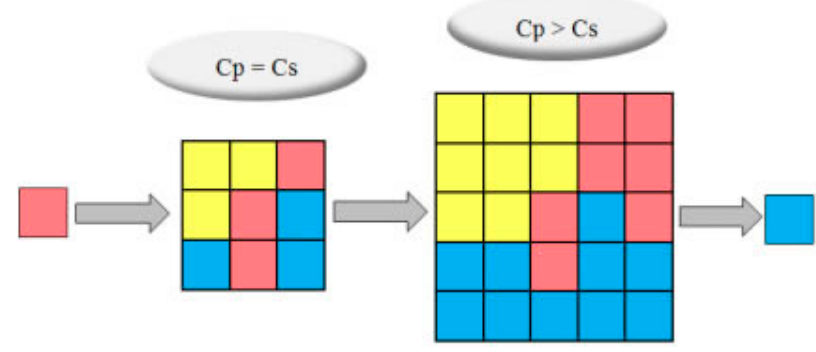
Figure 7. Illustration of space search. Remote Sens. 2018 , 10 , x FOR PEER REVIEW